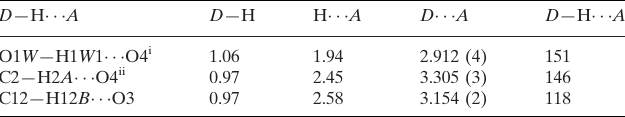
Hydrogen-bond geometry (A˚ , (cid:5)